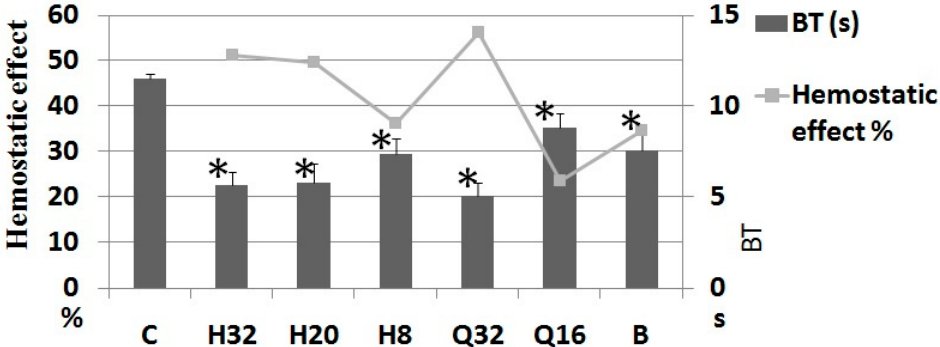
Figure 2. Bleeding time (BT) in mice and hemostasis effect of PS H and PF saponin extract ( n = 8); hemostatic effect = 100% × (blank group BT − drug group BT)/blank group BT; C: Control (0.2% CMC-Na solution); H: PS H (H32, 32 mg/kg; H20, 20 mg/kg; H8, 8 mg/kg); Q: PF saponin extract (Q32, 32 mg/kg; Q16, 16 mg/kg); B: Yunnan Baiyao (1 g/kg); * compared with 0.2% CMC-Na ( t -test p < 0.05).